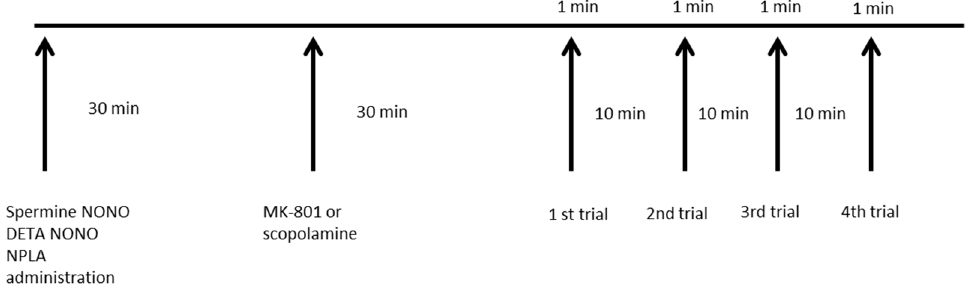
Figure 2. The daily chart of the experiment was repeated every day for 4 of 5 consecutive days (the acquisition phase). Control animals received vehicles in place of